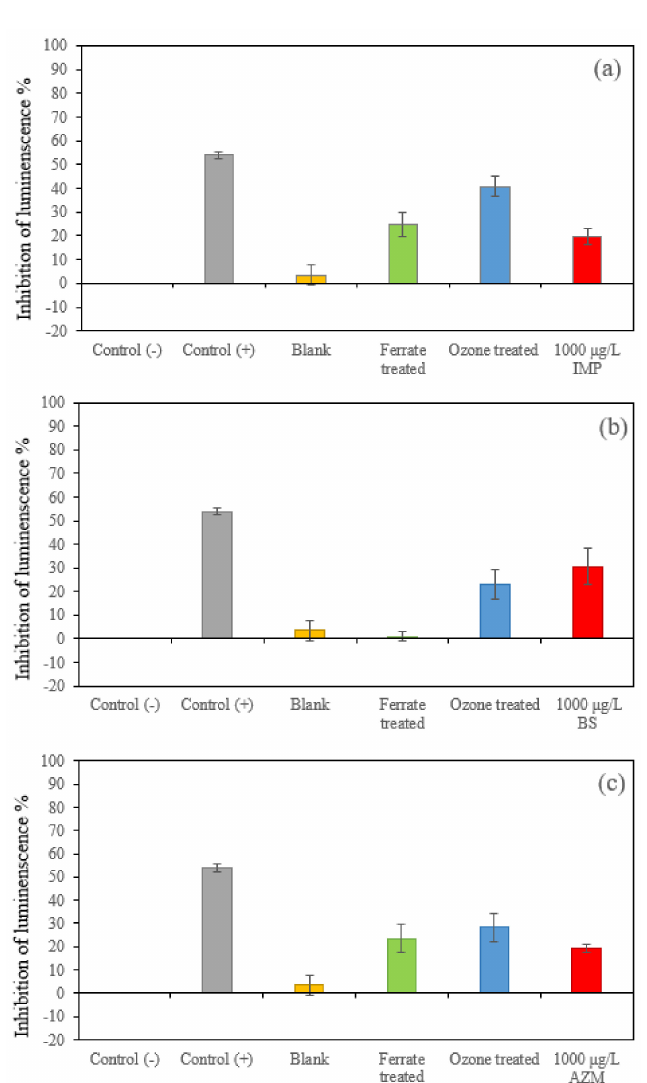
Figure 5. Toxicity of the blank (treated drinking water) and the target three compounds. (1000 µ g L − 1 ), with and without being treated by 0.036 mM ferrate(VI) and ozone at pH 7, re- spectively. ( a ) IMP samples, ( b ) BS samples and ( c ) AZM